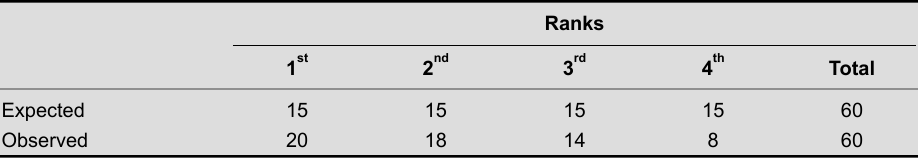
Expected and Observed Frequencies for Each Target Rank.